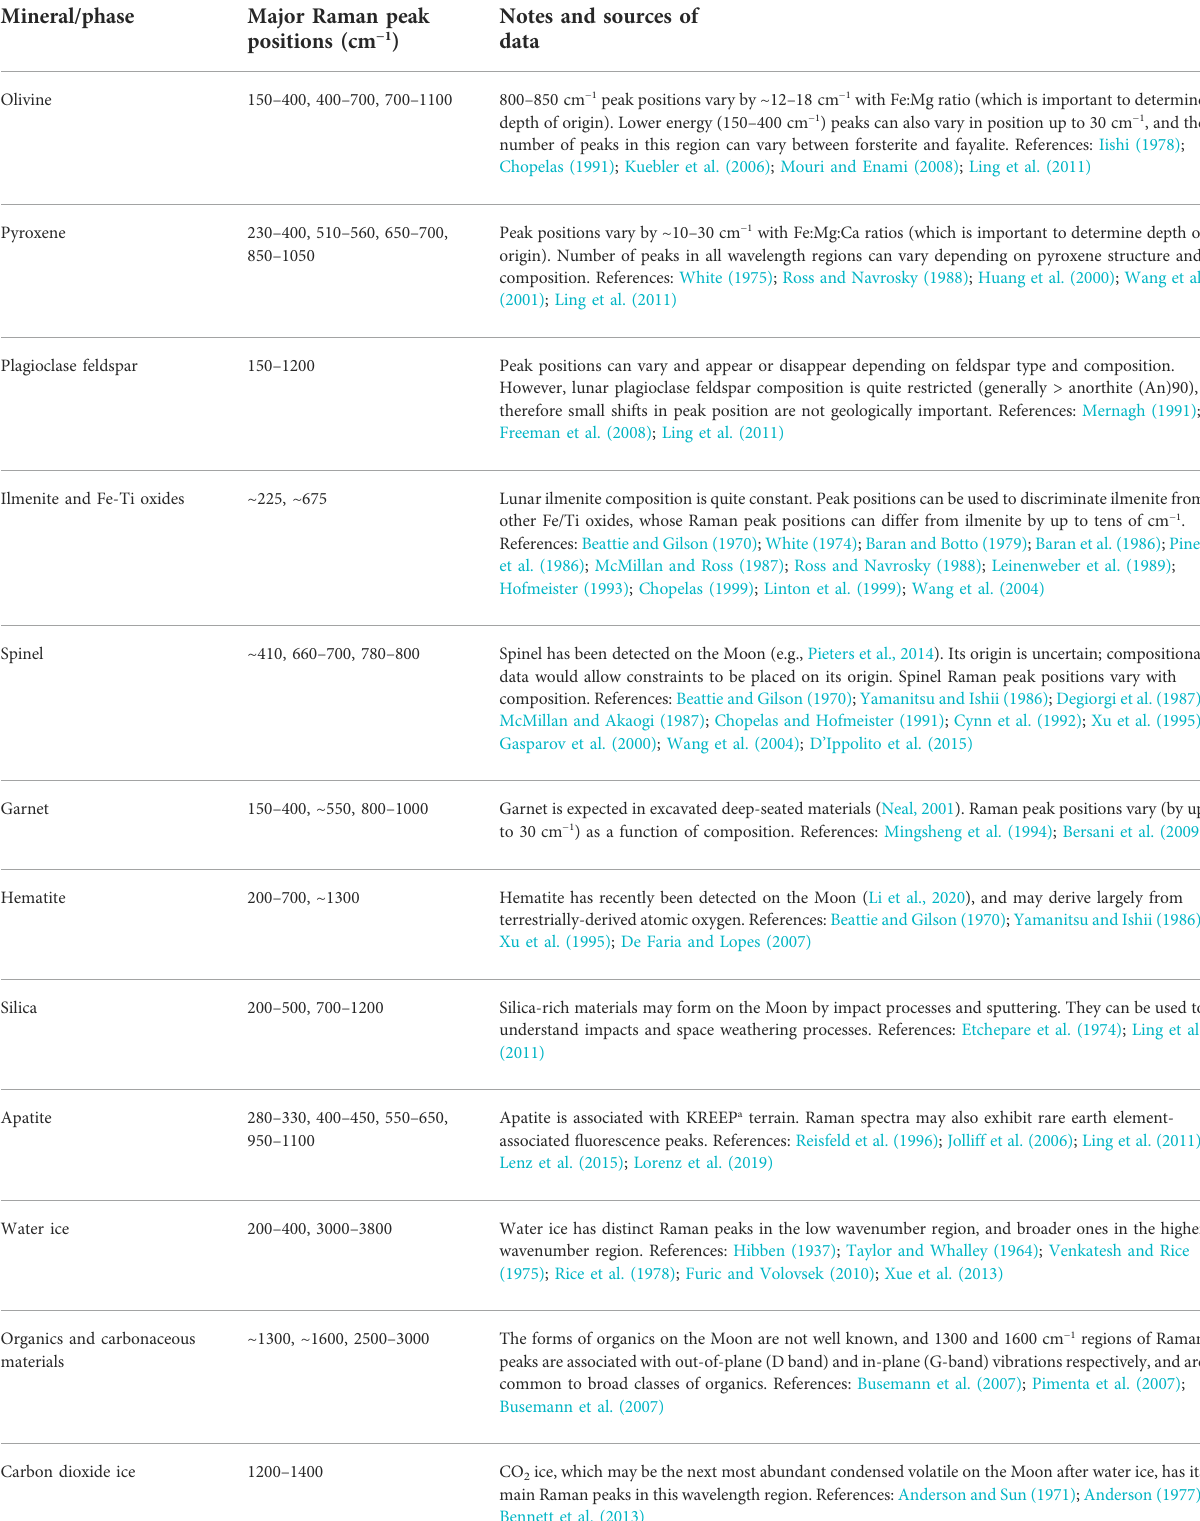
TABLE 2 Major peaks detected in Raman spectra of minerals and phases of interest for lunar